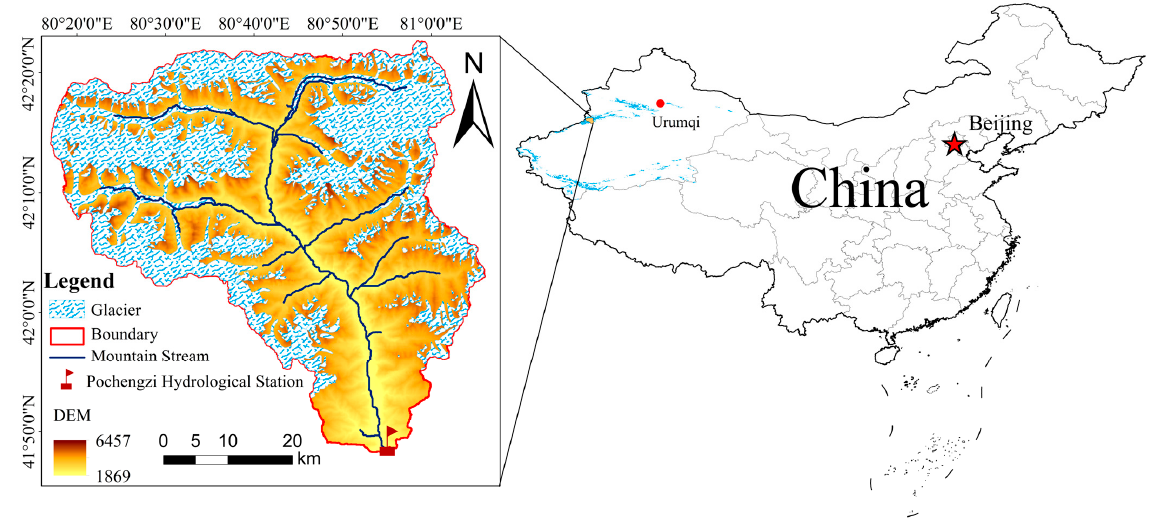
Figure 1. Location and glacier distribution in Muzati river basin.